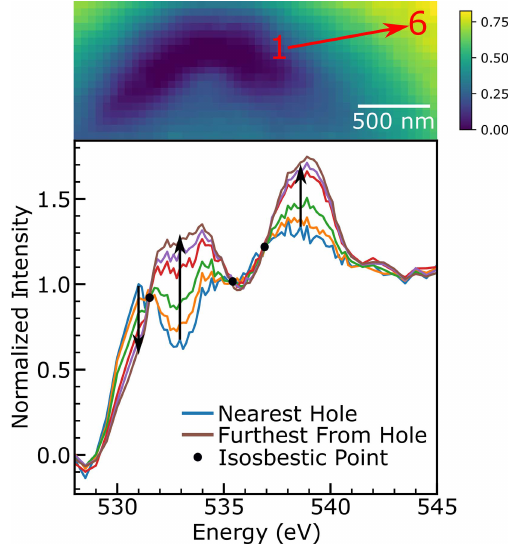
Figure 1 (Top) An optical density image of the stack region on FIB section 1B, sourced from the rim of the pellet, taken at 535 eV (pixel size 50 nm). The red numbers indicate the approximate location of the first and last regions from the central hole. (Bottom) Spectra taken from six different regions (determined by cluster analysis) on FIB section 1B. The blue trace is nearest to a defect in the sample, the intermediate regions are orange, green, red and purple in order of increasing distance from the defect, and the brown trace is furthest from the defect in the sample. The arrows indicate how the spectra change with increasing distance from the defect. These spectra show isosbestic points (black circles), which are a clear indicator of a mixture of only two different oxygen species. Isosbestic points are located at 531.5, 535.3 and 536.9